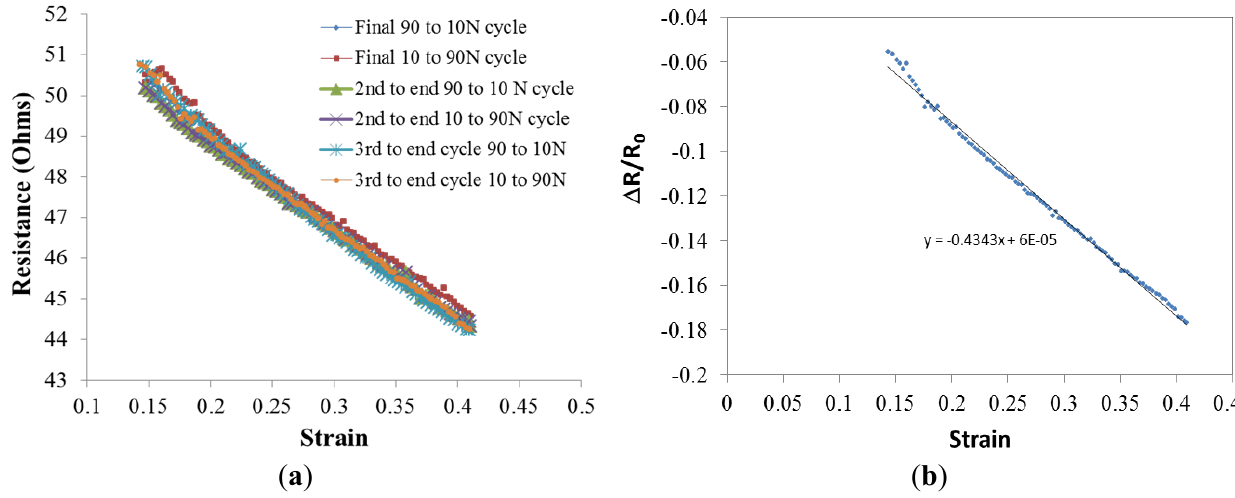
Figure 5. Strain Gauge. The resistance vs. strain values taken from the final six segments of cycling experiment show the “aged material” displays a linear relationship between resistance and strain ( a ). The slope of the ( ∆ R − R cycle, has been used to calculate the strain gauge factor ( b